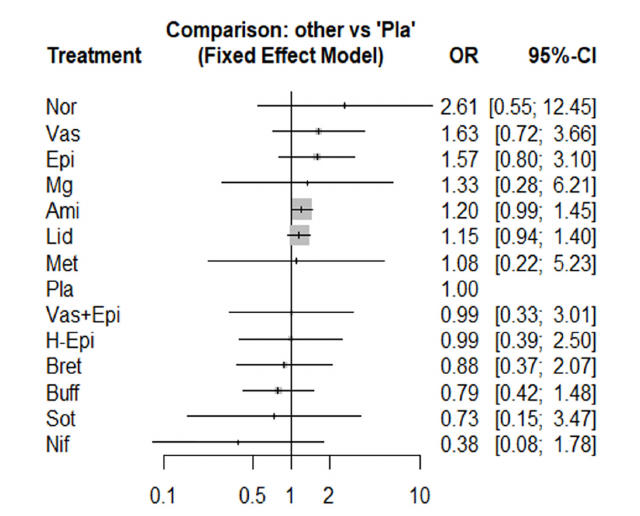
Figure 3. The forest plot of the network meta-analysis comparing the odds ratios on the survival to hospital discharge among the medications.